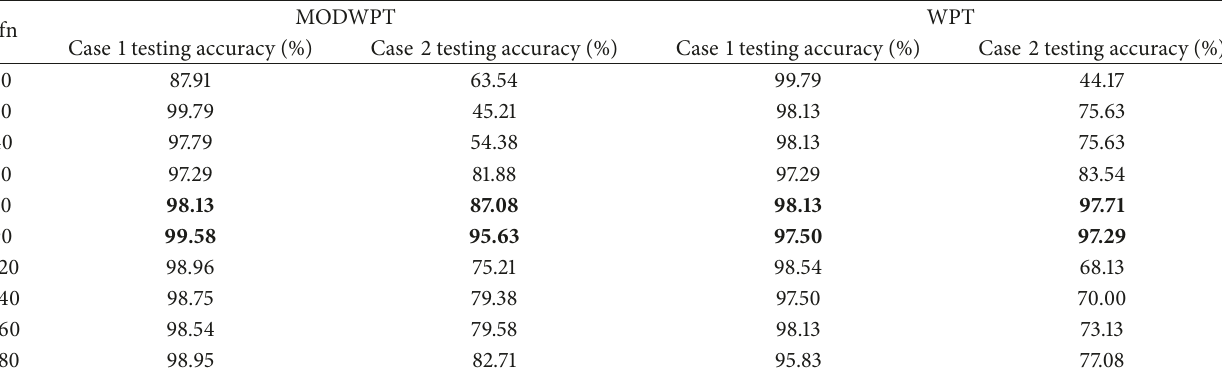
Table 8: Bearing fault diagnosis results obtained by